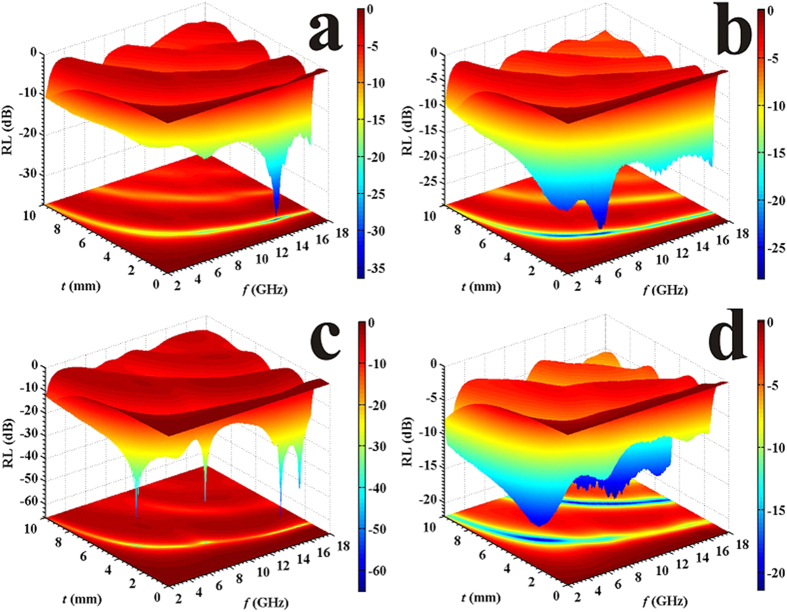
The reflection losses of the composites with different ratio between Fe3O4 and RGO.